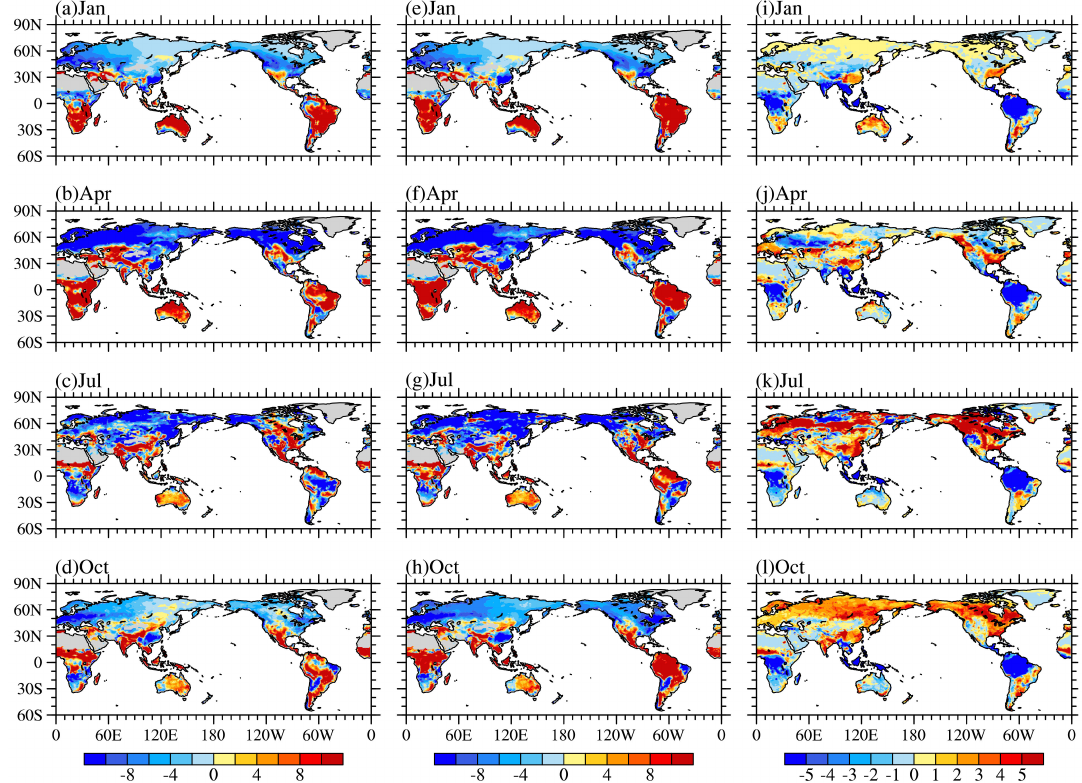
Figure 11. Spatial distribution of global latent heat flux (units: W/m 2 ): ( a – d ) difference between CLM4.5 and FLUXNET, ( e – h ) difference between CLM4.0 and FLUXNET, and ( i – l ) difference between CLM4.5 and